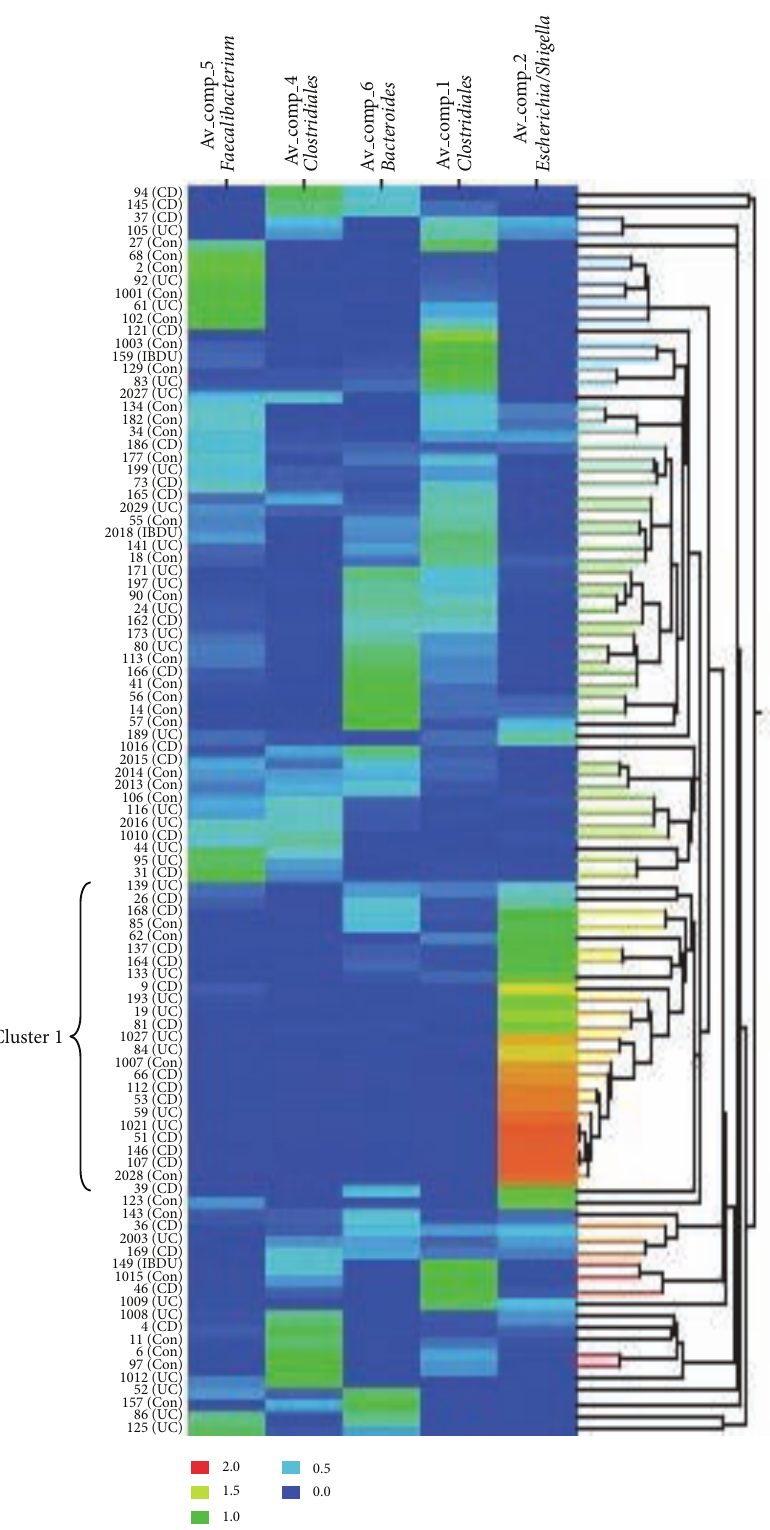
Figure 3: Data matrix of the amount of components 1, 2, 4, 5, and 6 in the stool samples. The graded colors indicate the abundance of a particular component in a sample. Red color indicates a high amount of the component, and blue color indicates a low amount of the component. To the left of the matrix, sample numbers are shown together with the diagnosis UC (Ulcerative colitis), CD (Crohn’s disease), and Con